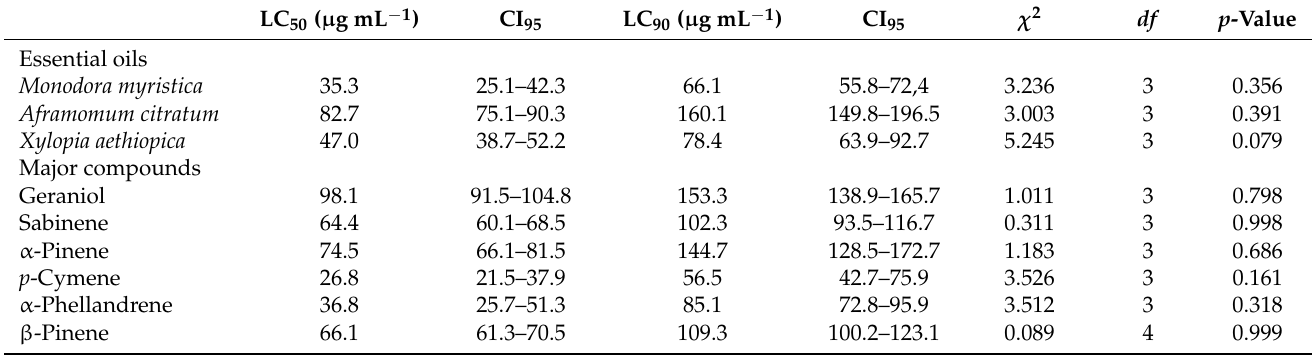
Table 4. Insecticidal activity of Monodora myristica , Aframomum citratum , and Xylopia aethiopica essential oils and their major constituents on Culex quinquefasciatus third instar